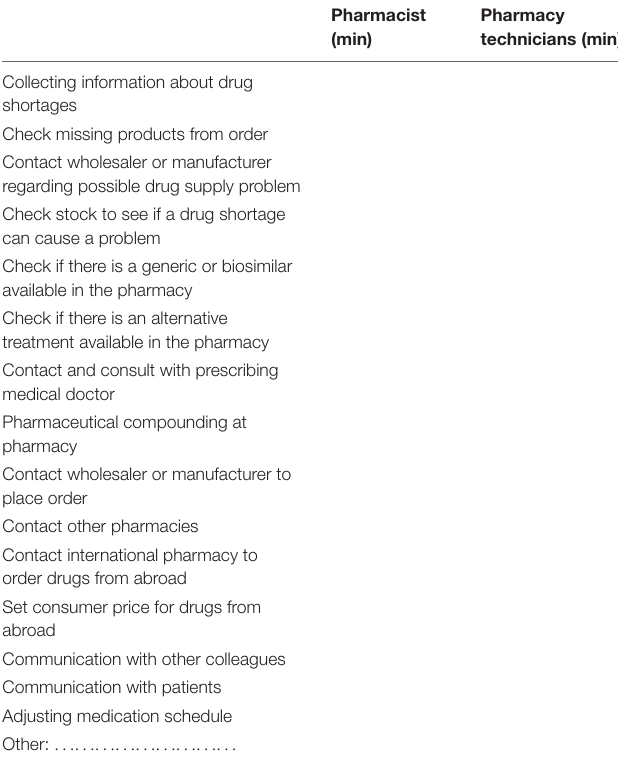
TABLE 1 | Template to report time spent on drug supply